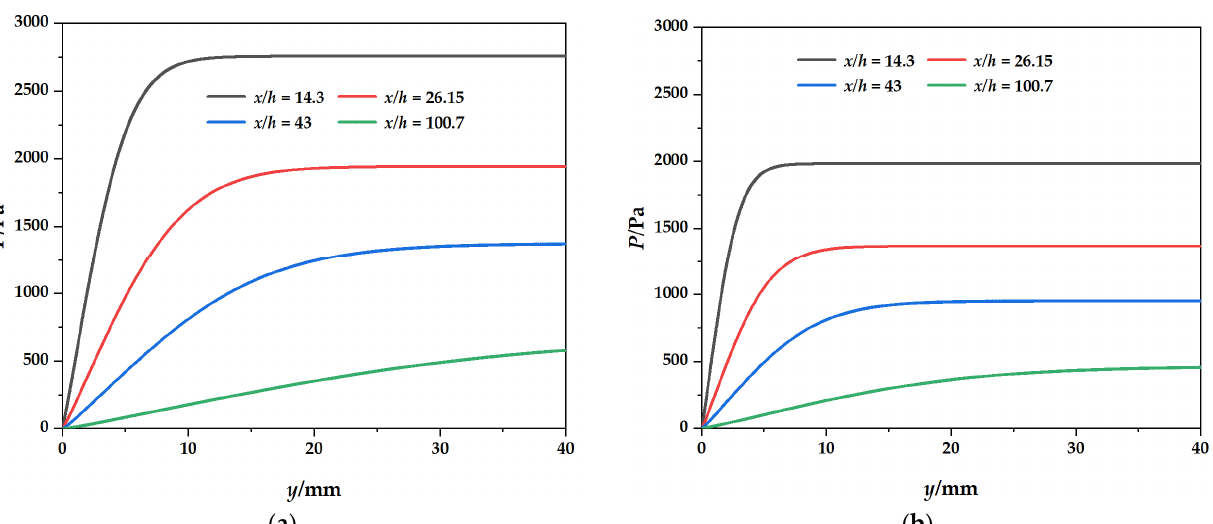
( b ) Figure 10. Lift index with different x / h over logarithmic spiral wall surfaces at ( a ) x / R = 1 and ( b ) x / R = 2/3. 3.3.3. Non-Dimensional Slot Height h/R 0 Figures 11–13 show the velocity, pressure, and lift index profile of the u i = 10 m/s and x = 86 mm, but with differing h / R 0 . In the logarithmical spiral of x / R = 1, u m rose from 2.2 m/s to 4.5 m/s with the increase of h / R 0 from 0.0073 to 0.0291, while in the spiral of x / R = 2/3, u m dropped from 7.6 m/s to 3.8 m/s, with faster decay at the y -direction. The positive- growth profile of pressure distribution first increased markedly at distance smaller than y = 20 mm ( x / R = 1) or y = 10 mm ( x / R = 2/3), and then slowed down to reach a constant value. The observed lift index decreased with increasing particle diameter, first sharply and then slightly (Figure 13). It is apparent that the lift capability of jet flow in a logarith- mical spiral of x / R = 1 is better than that of x / R = 2/3.